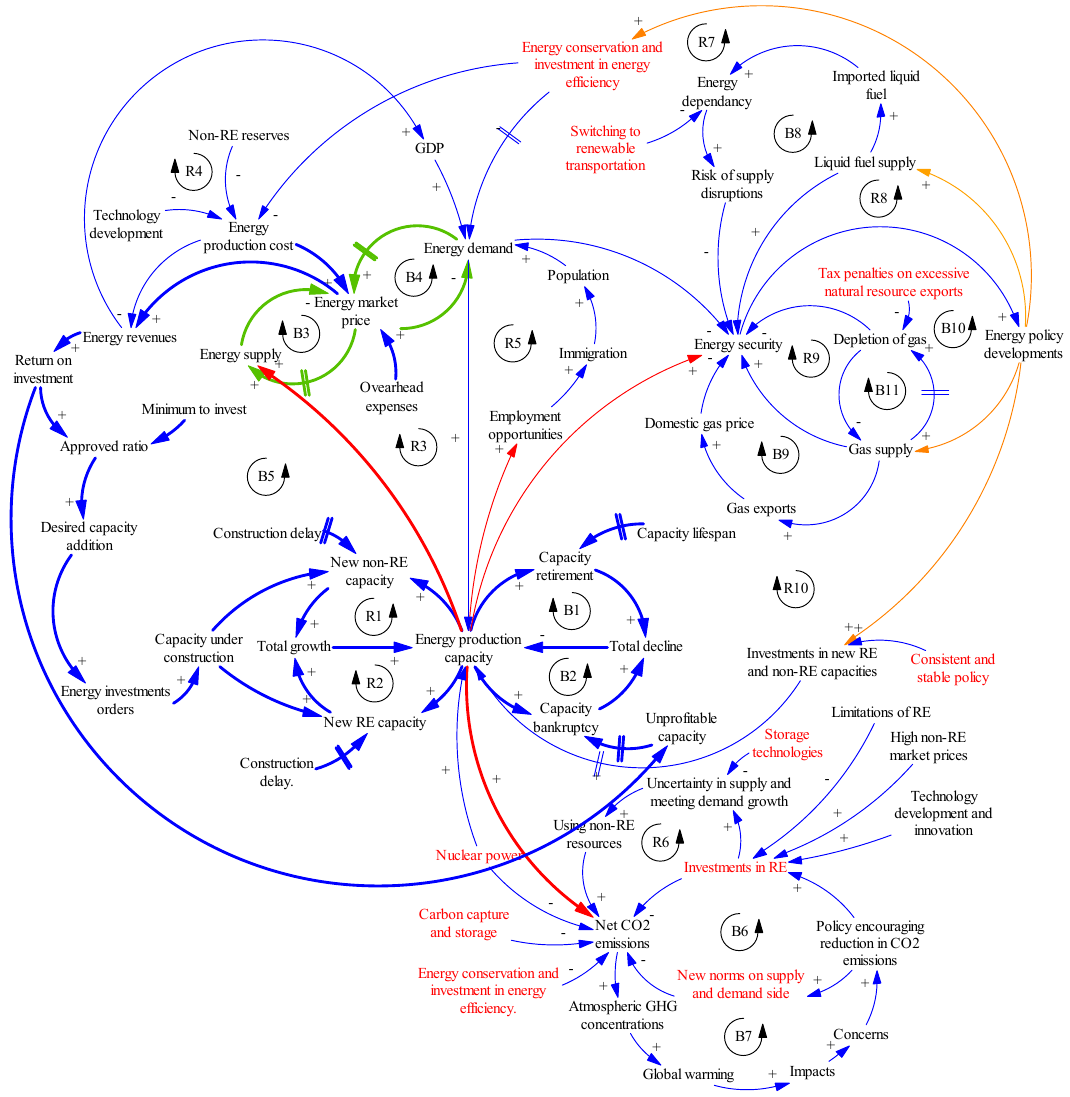
Figure 2. Feedback loops from Laimon et al. [1] causal loop diagram (CLD) replicated in the stock-flow model (indicated in bold). The CLD contains 21 feedback loops including ten reinforcing loops (R1 to R10) and eleven balancing loops (B1 to B11). This CLD highlights the main components of the energy sector linked to Australia’s energy policy including energy resources (loops R1 and R2); energy production, supply and demand (loops R3, B3 and B4); energy economics (loops B5 and R4); energy emissions and energy emissions policies (loops R6, B6 and B7); and energy policy developments (loops R7, B8, R8, B9, R9, B10, R10 and B11). Parameters in red are missing or poorly performing in the Australian context.